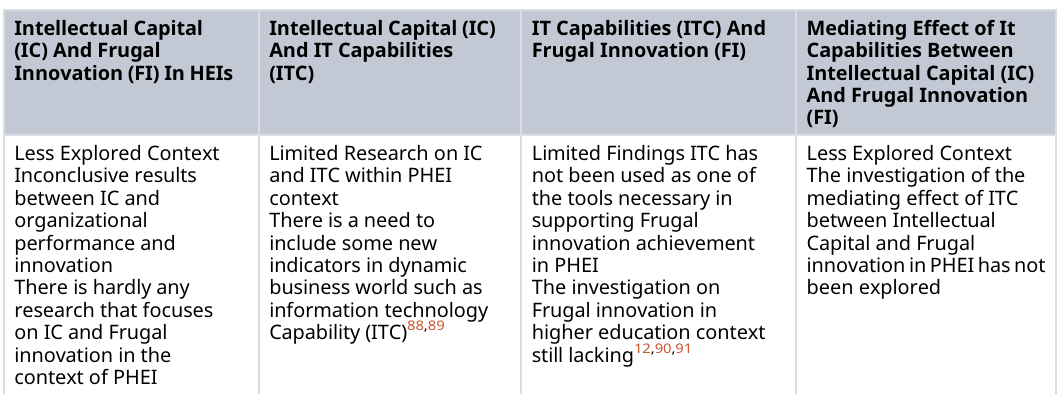
Table 5. Research